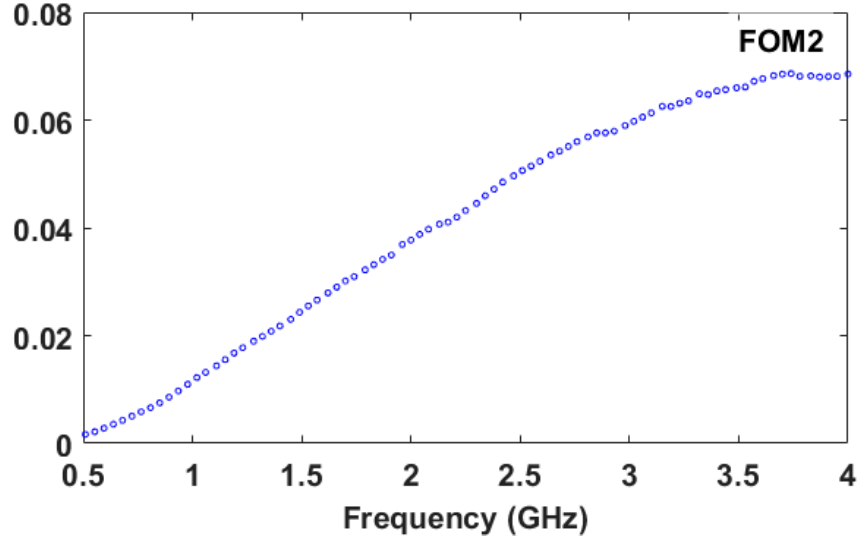
Figure 12. The FOM2 is depicted from the frequency range of 0.5-4.0 GHz.